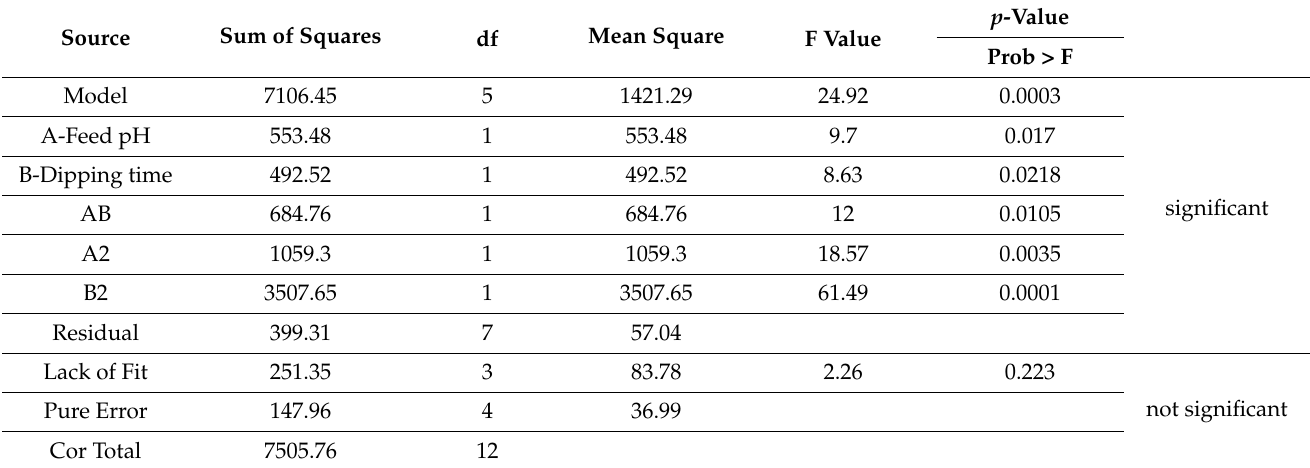
Table 4. Analysis of variance (ANOVA) for oil contact angle response.